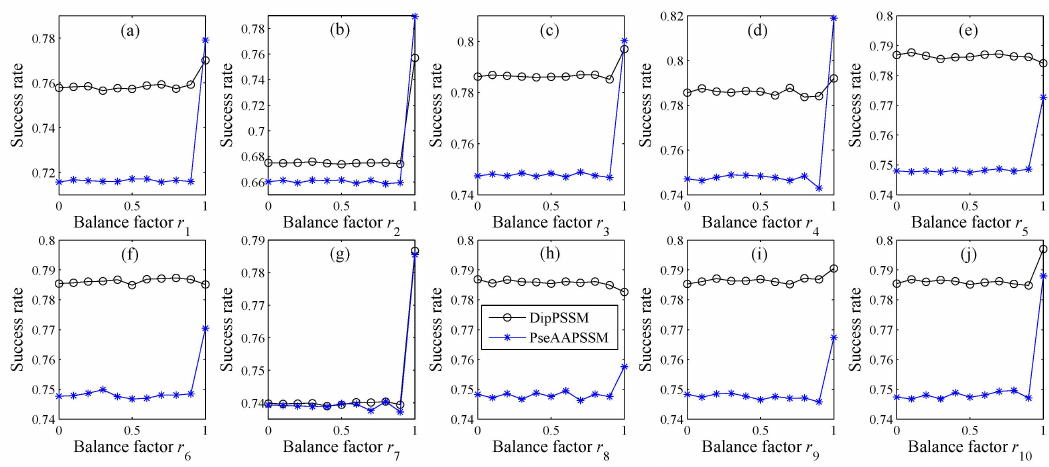
Figure 3. Success rate comparison for different r i with our representations on Dataset 2, where each subplot, from ( a ) to ( j ), respectively represents each sub-nuclear